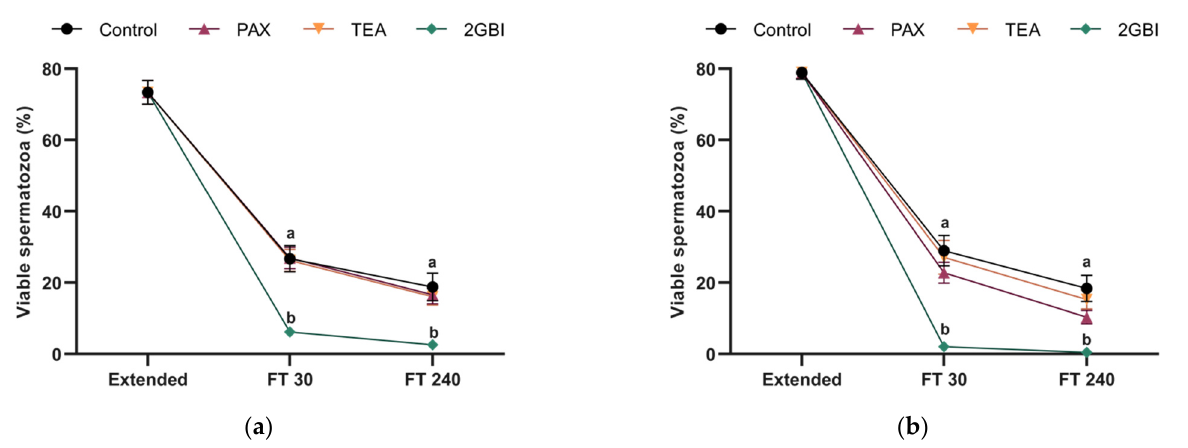
Figure 1. Percentages of viable spermatozoa (SYBR14 + /PI − ) in extended and frozen–thawed (FT) samples at 30 min and 240 min post-thaw. In Experiment 1 ( n = 8), TEA, PAX, and 2-GBI blockers were added to LEY medium at 15 °C ( a ), whereas in Experiment 2 ( n = 9), they were added to LEYGO medium at 5 °C ( b ). Different superscripts indicate significant differences ( P < 0.05) between samples within the same time point. Results are given as mean ± SEM.